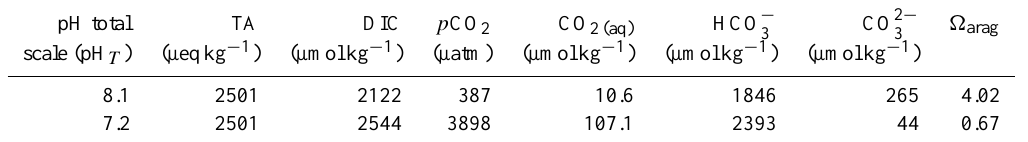
Table 1. Carbonate chemistry parameters of the treatment and the control calculated from pH, total alkalinity (TA), temperature (25 ◦ C) and salinity (40) using the program CO2SYS (Lewis and Wallace, 1998). DIC: dissolved inorganic carbon; (cid:127) arag : aragonite saturation state. pH